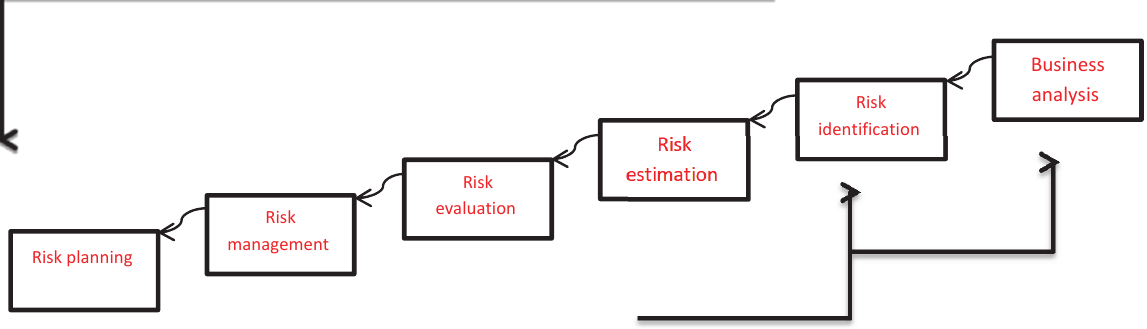
Fig. 1 . risk management process (EsmaeilNejadAhangari, 2012: